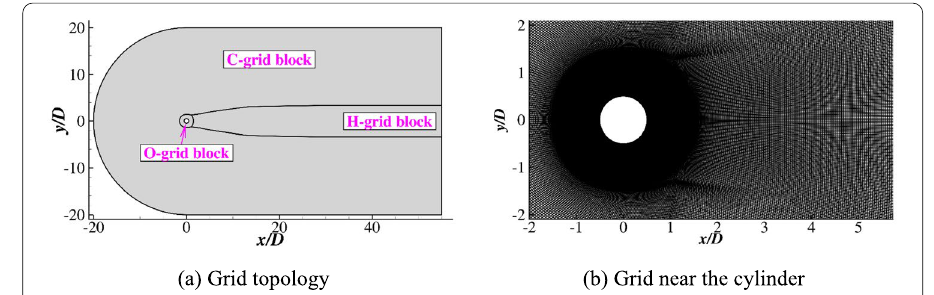
Fig. 2 Computational grid in the x-y plane